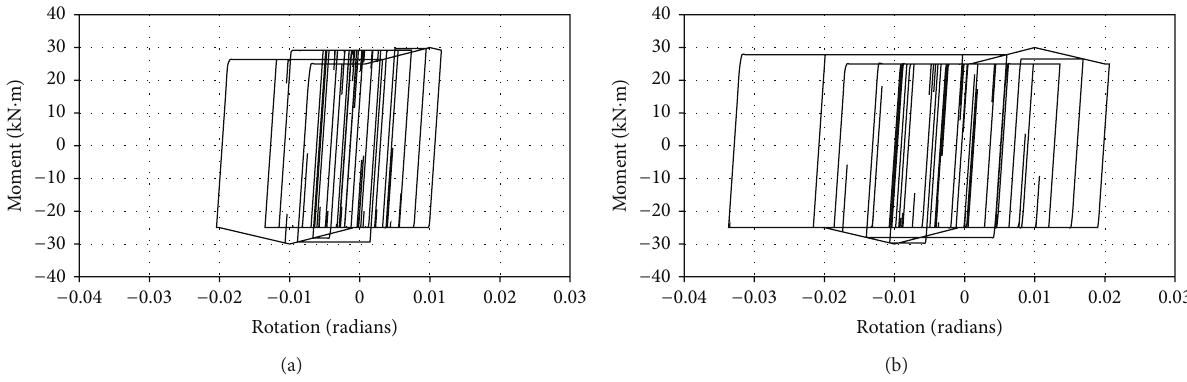
Figure 7: G3 spherical bearing moment-rotation response at the south abutment for (a) curved longitudinal direction and (b) skewed longitudinal direction.